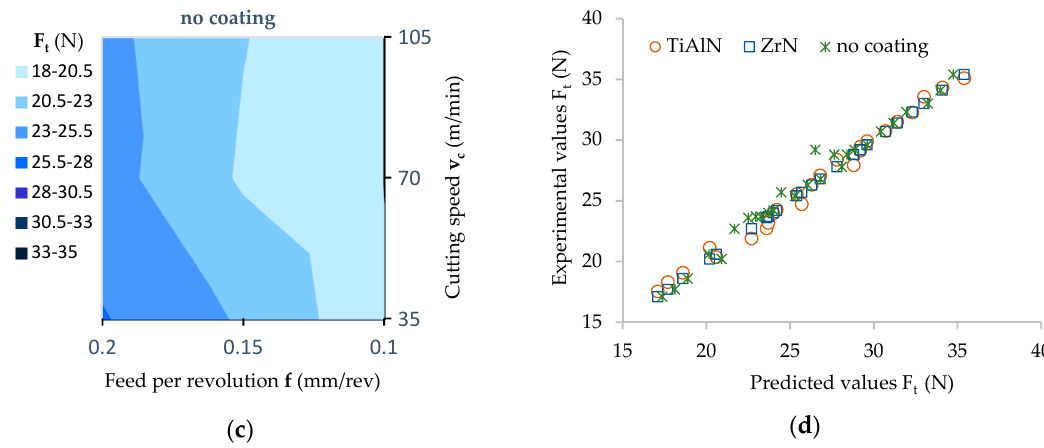
Figure 13. Influence of the feed value on the value of the thrust force (contour diagrams): ( a ) For a TiAlN coated drill; ( b ) for a ZrN coated drill; ( c ) for an uncoated drill; ( d ) correlation between the experimental and predicted values of thrust force determined for the coated and uncoated tools. Table 4. Significance level of the effect of cutting parameters on the average thrust force (F t ).